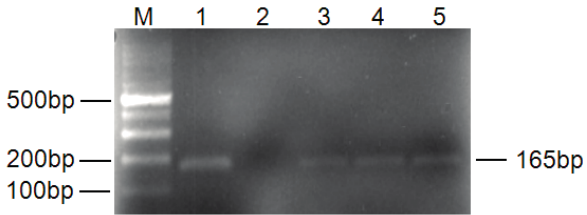
Figure 1. PCR amplification of tubulin β chain gene from G. thurberi